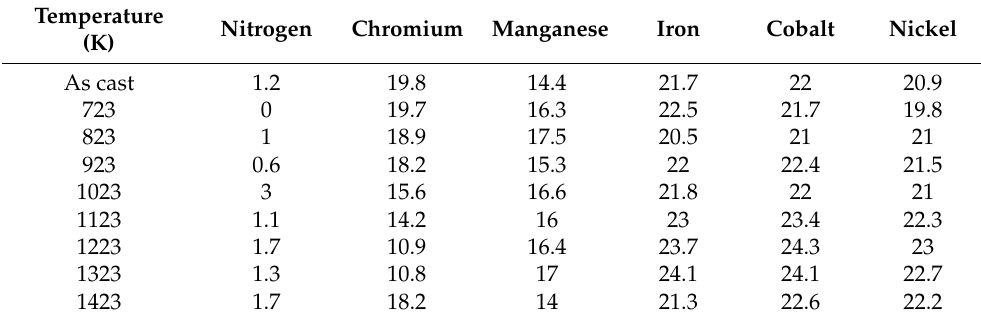
Table 2. EDS semi-quantitative chemical compositions, in atomic %, of FCC matrix of cold-rolled samples. Relative uncertainty on data is less than 2% except for N (30%) and Mn (7%). Temperature